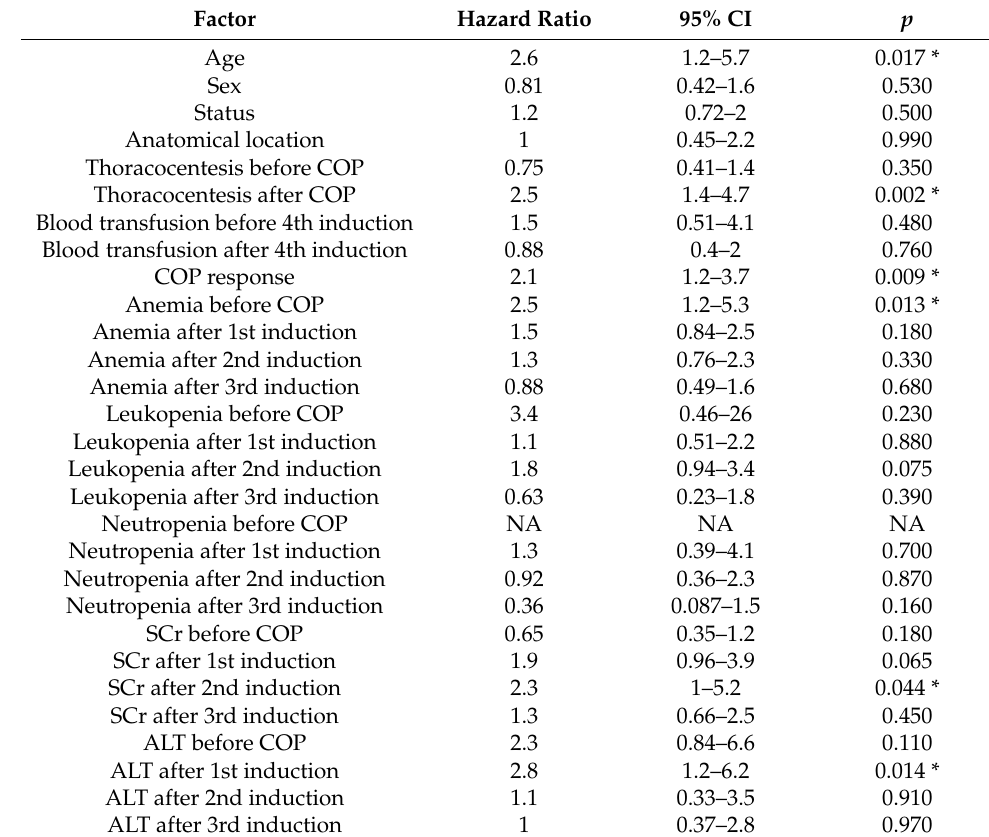
Table 4. Cox-regression analysis of 76 cats treated with COP